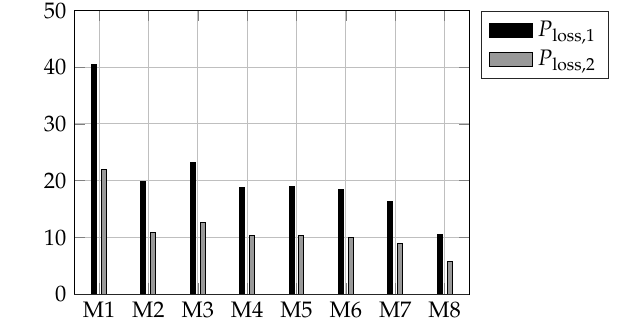
Figure 15. LPTN model of the simplified case study for the stator and the